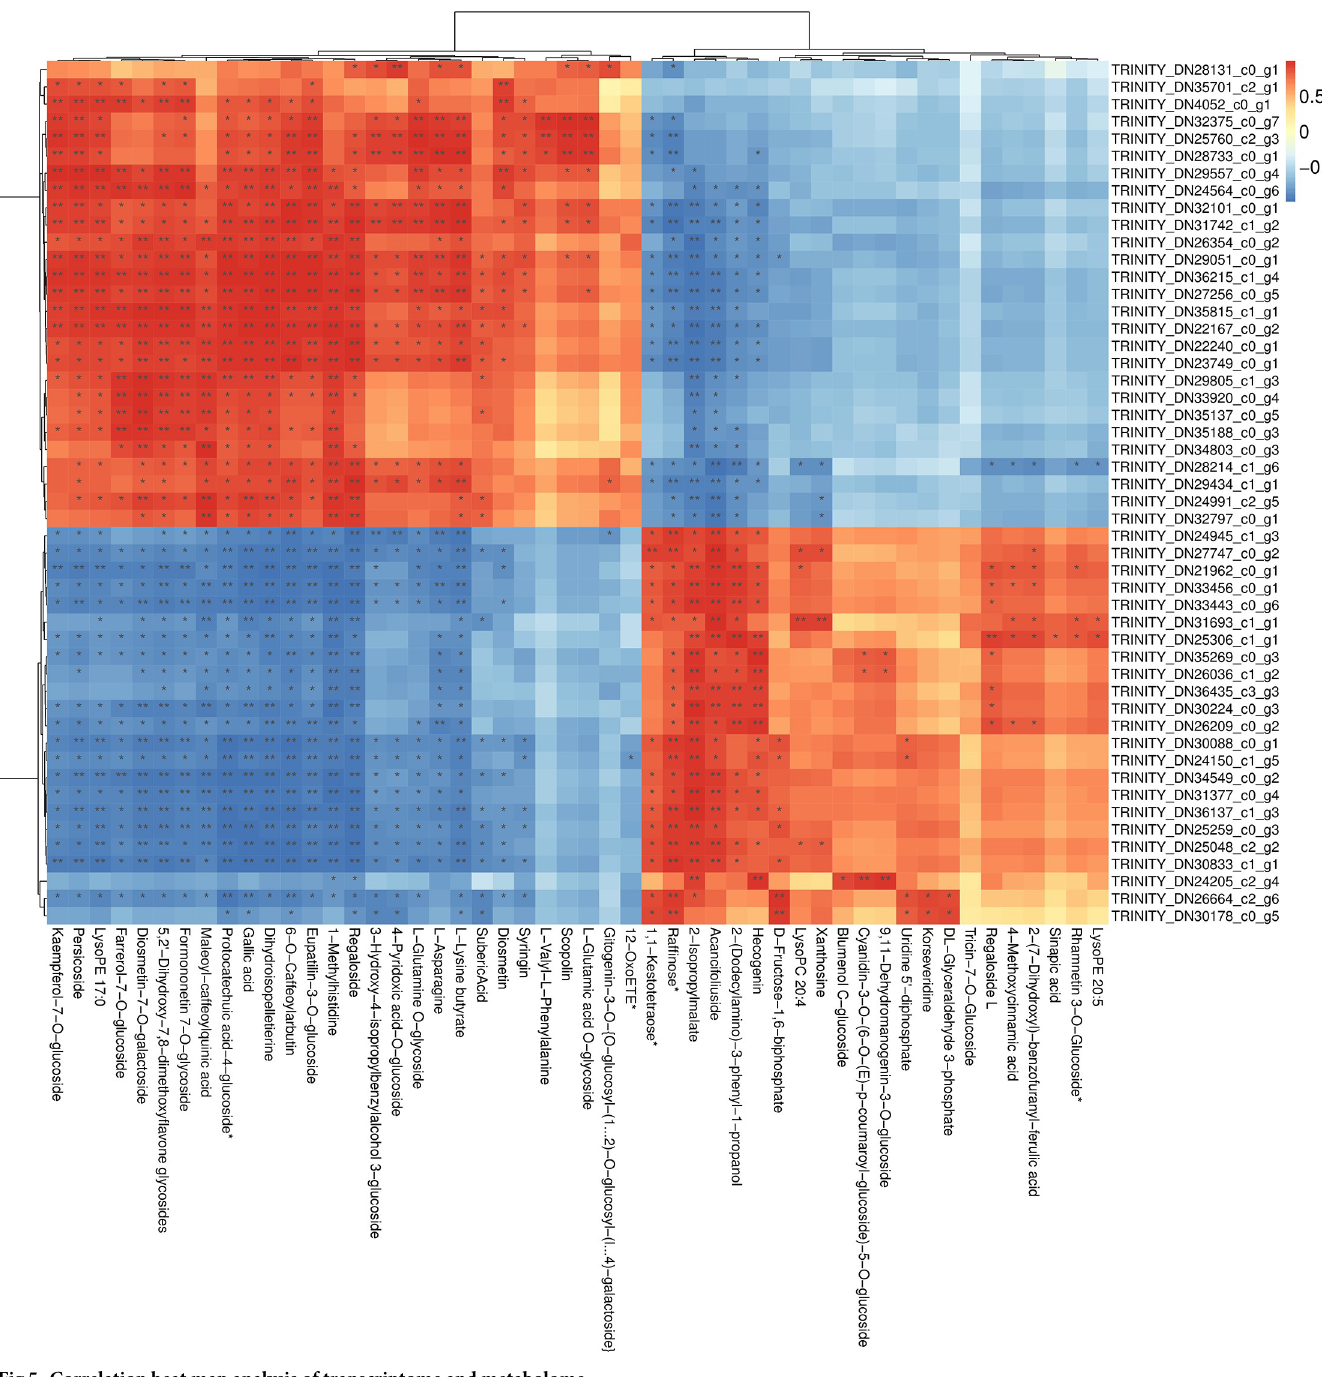
the cell membrane, triggering the process whereby Ca 2+ enters the cell via ion channels on the cell membrane, and activating the cell’s defense or immune response through Ca 2+ signaling. In this study, it was found that at least three channel proteins—namely, COLD, CNGCs and CRLK—interact with Ca 2+ to transmit cold signals across the root cell membrane in H .